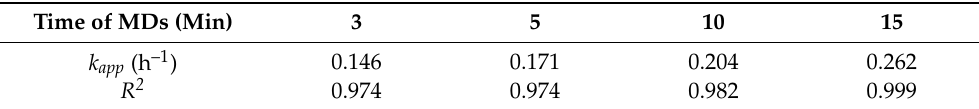
Table 2. First-order kinetic constant k app and corresponding linear correlation coefficient R 2 for Ta 2 O 5 coatings formed at various stages of the MDs.